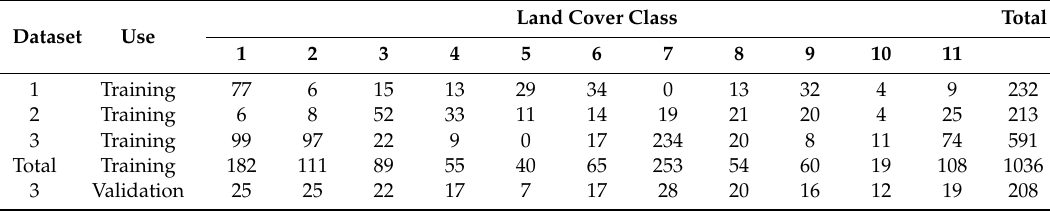
Table 3. Training and validation